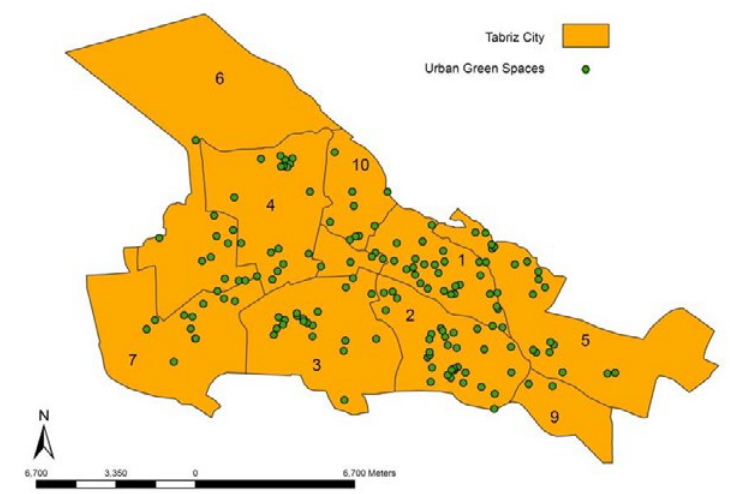
Fig. 8: Distribution of parks and urban green spaces Fig 8: Distribution of parks and urban green